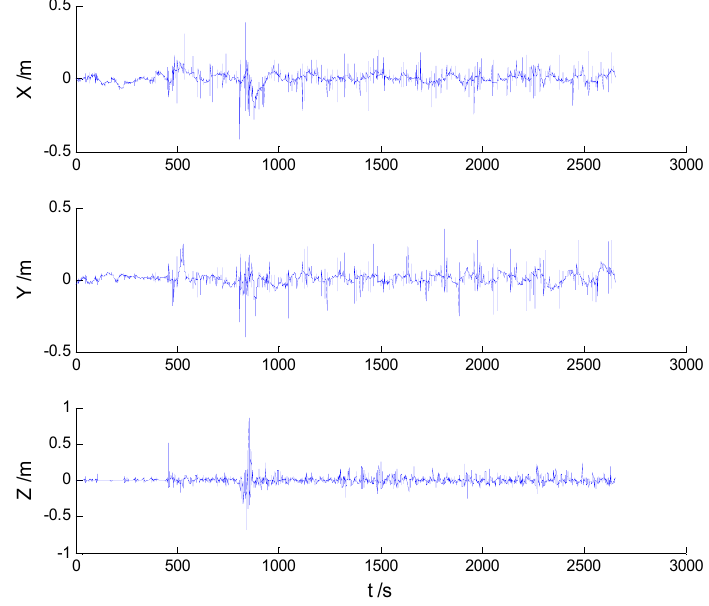
Figure 2. Position errors of the Kalman filter (KF) algorithm.